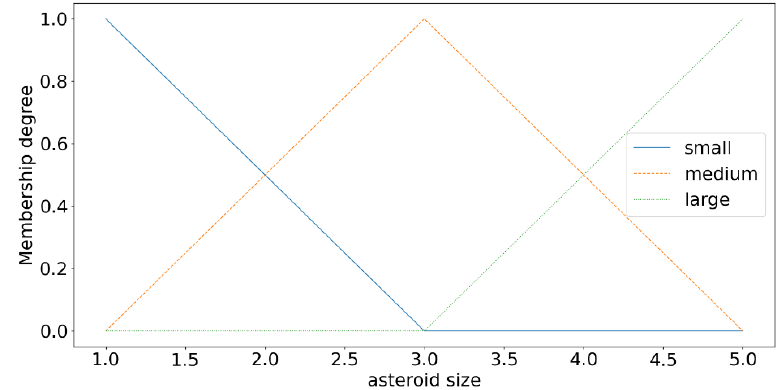
Figure 7. Asteroid size fuzzy set.